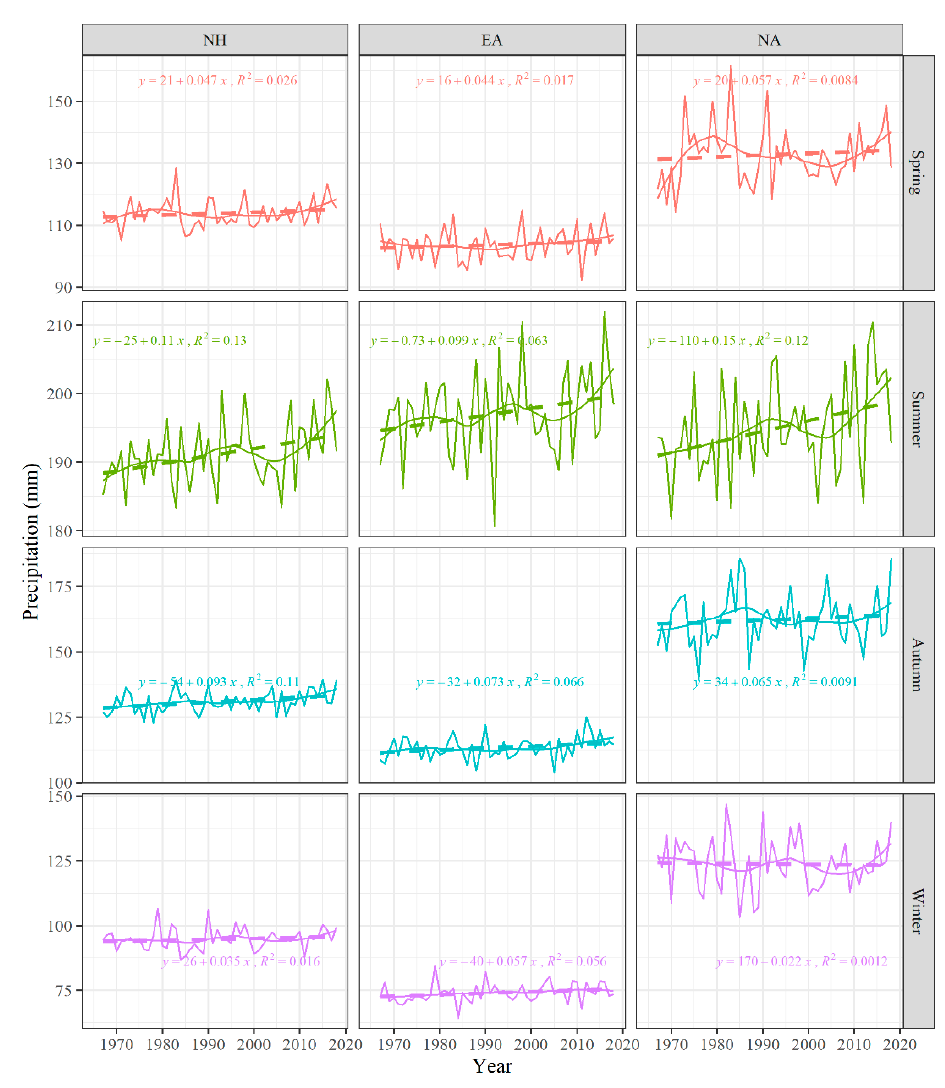
Figure 5. Variability in seasonal precipitation of NH, EA, and NA during the 1967–2018 period, with 10-year LOESS-smoothed values. Equations in the figure are for fitted linear regressions (dashed lines).